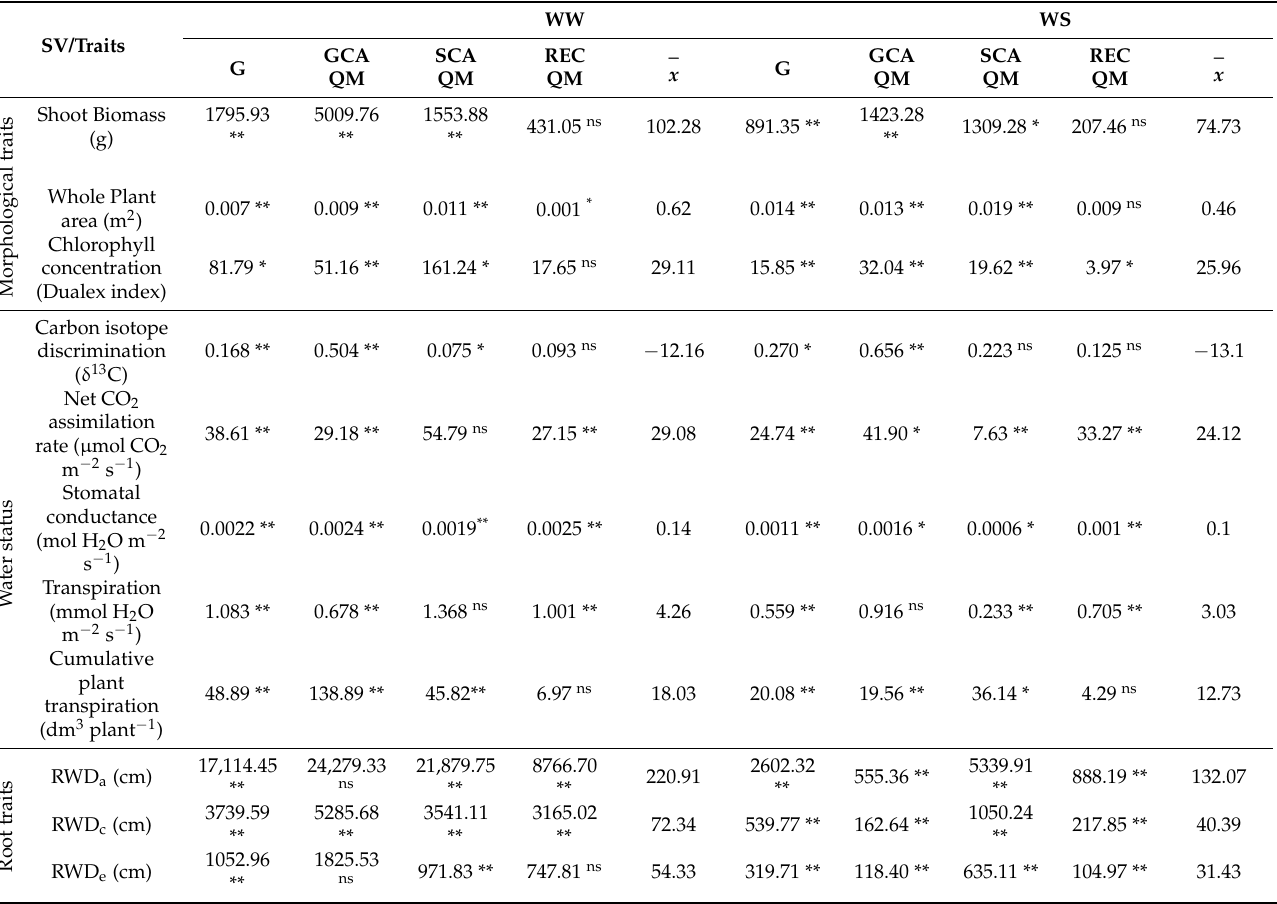
Table 1. Summary of diallel analysis of variance according to Method I of Griffing (1956), containing the estimates of means for morphological traits, water status, and root traits of four parents and their hybrid combinations of popcorn grown under contrasting water conditions (WW and